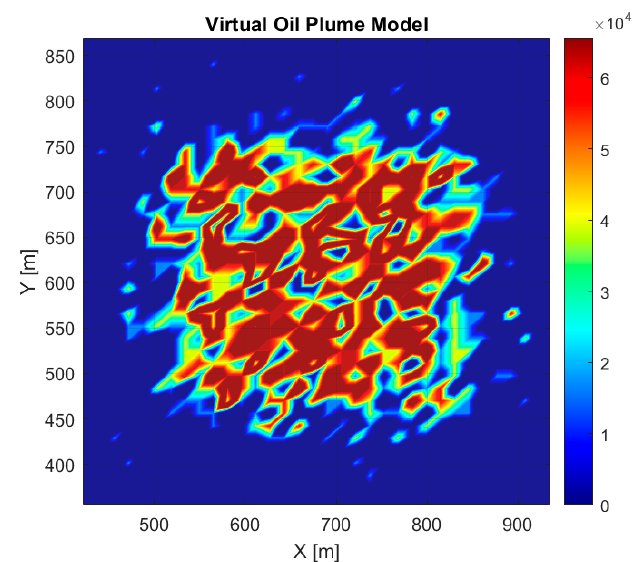
Figure 2. A virtual oil plume model, of approximately 400 m by 400 m, generated in the simulation domain within a 1000 m by 1000 m space, presented as a density plot over an equally spaced mesh grid.